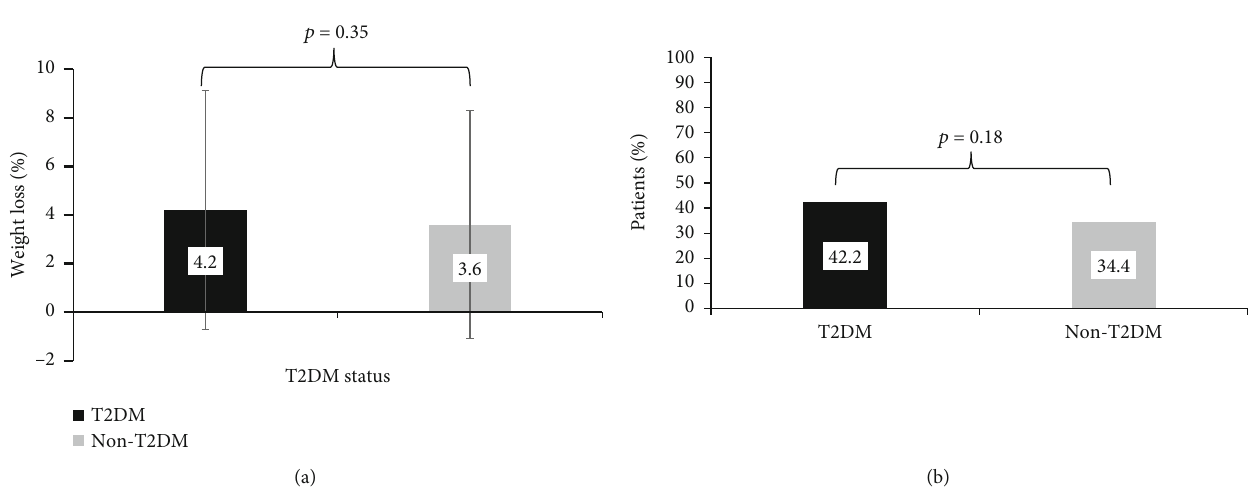
Figure 2: (a) Mean percent weight loss at 6 months by T2DM status at baseline ( p = 0 : 35 ), (T2DM, n = 83 ; non-T2DM, n = 64 ). (b) Weight loss of ≥ 5% body weight at 6 months by T2DM status at baseline ( p = 0 : 18 ), (T2DM, n = 83 ; non-T2DM, n = 64